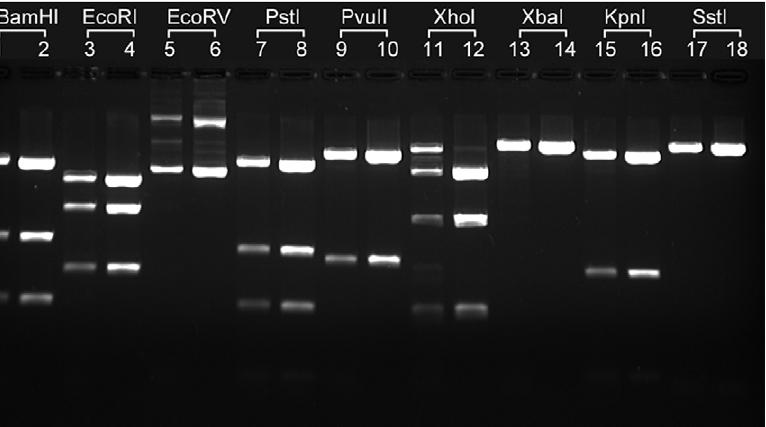
Figure 3. NID crude lysates perform well in digestion reactions. 2 ml bacterial cultures containing plasmid B254 were processed according to the NID miniprep plasmid isolation procedure with (complete procedure, CP) or without (crude lysate, CL) isopropanol precipitation. 50 mM MgSO 4 was added to the CL to chelate 50 mM EDTA in the extraction buffer. All CL samples were digested in 15 m l NEB 1 buffer (no salt), and 1 m l CL was used for digestions. CP samples were digested in the specific NEB buffers recommended for the restriction endonuclease, and 0.5 m l DNA was used for every reaction. Samples were incubated with 5u of each enzyme at 37 u C for 1 hr. The reaction products of CL digestion were loaded in odd- numbered lanes, while digestion products of CP DNA were loaded in even-numbered lanes.